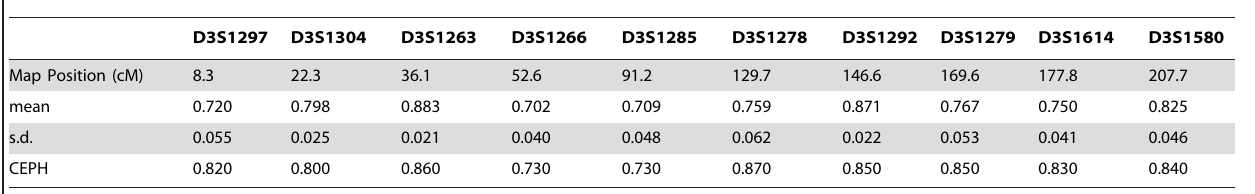
Table 1. Averaged heterozygosities ( H E ) for the 10 analyzed